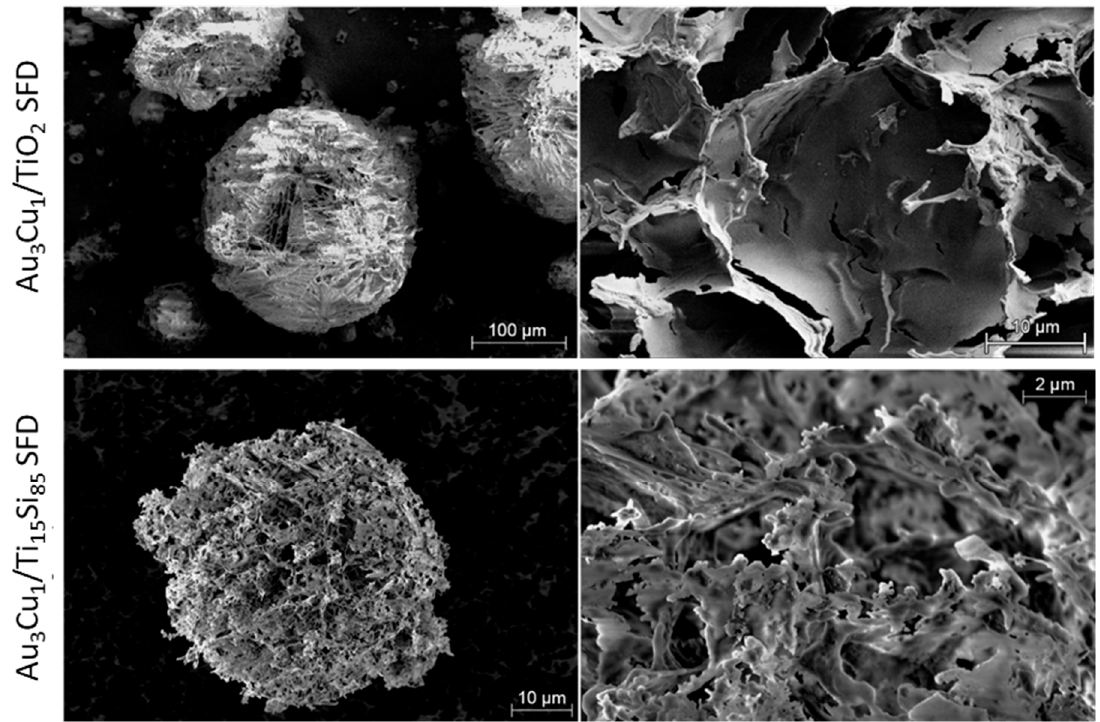
Figure 4. SEM images of the Au 3 Cu 1 —containing spray-freeze dried powders.